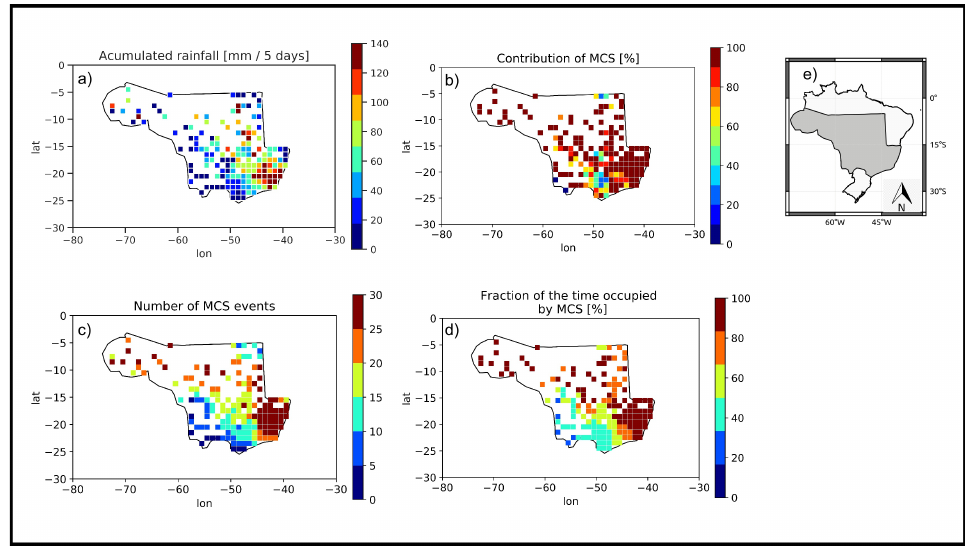
Figure 8. ( a ) Accumulated rainfall recorded from 1 January 2012 to 5 January 2012 over the central region of Brazil (R2); ( b ) fraction of rain on days that had MCS record over the rain accumulated in five days; ( c ) number of MCS events recorded in five days; ( d ) fraction of the days that had MCS records. ( e ) Analyzed